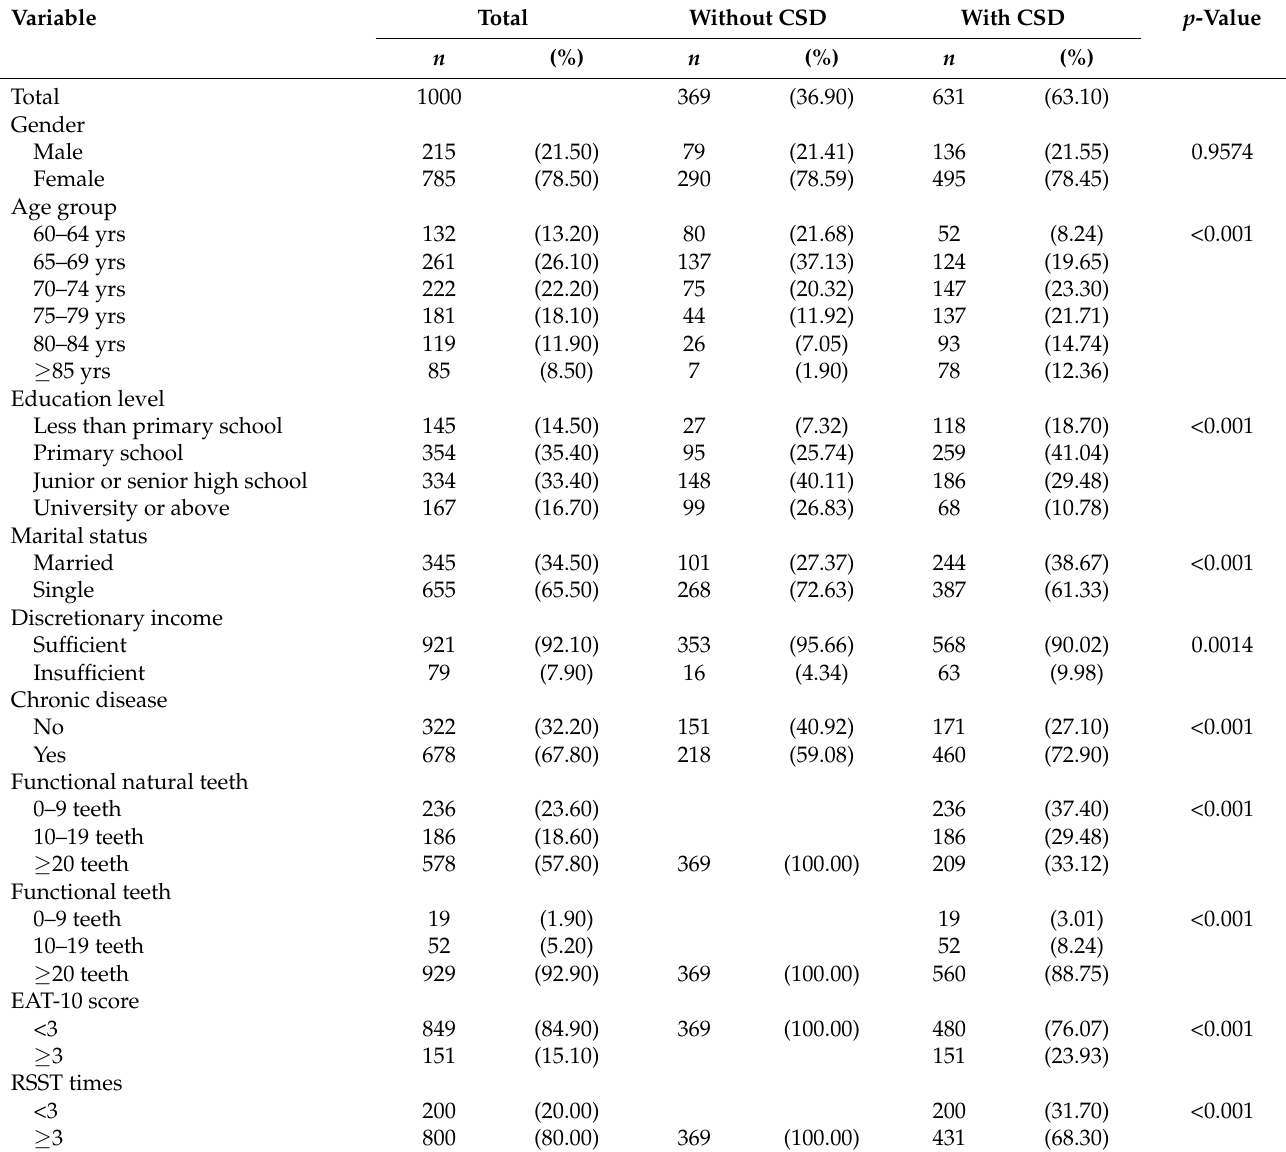
Table 1. General characteristic of